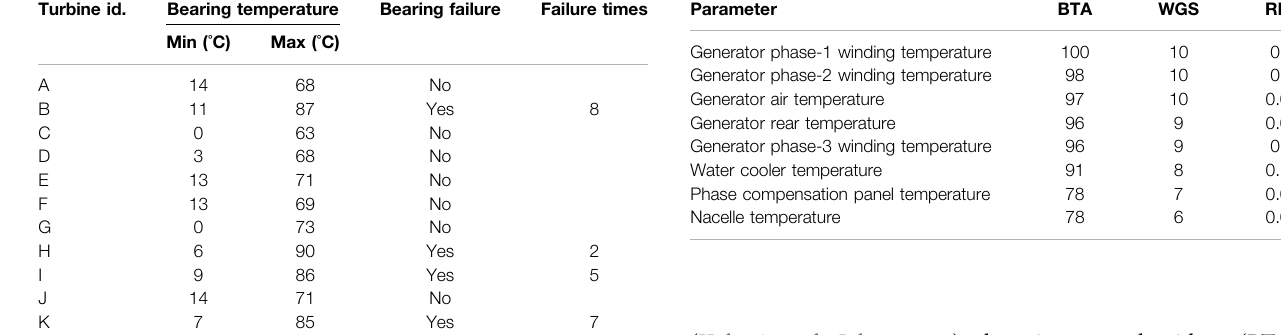
TABLE 1 | Dataset description. Turbine id.